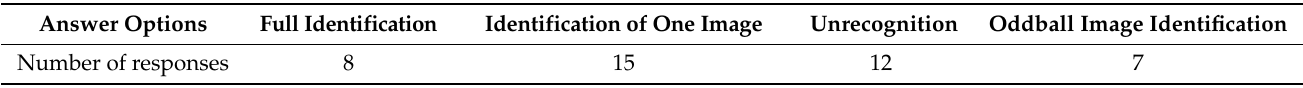
Table 1. Quantitative characteristics of answer options in experiments with the presentation of dual visual images-illusions and correct identification of the oddball image.